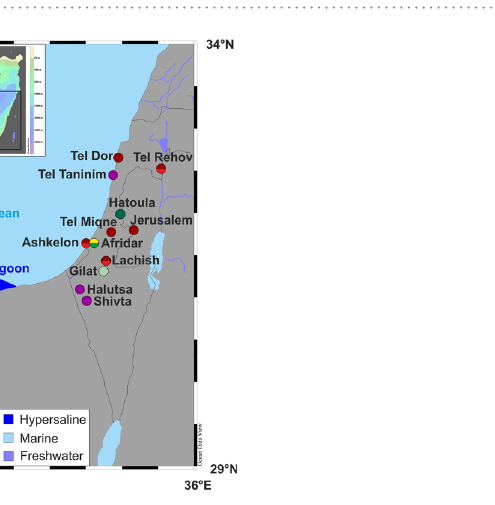
Figure 2. Map of archaeological sites in the southern Levant from the beginning of the Pre-Pottery Neolithic (PPN: ~9,700 years BCE) until the Byzantine period (BYZ: 300 to 600 CE), from which S . aurata remains were analysed for their phosphate oxygen isotope composition. Also indicated is the location of the hypersaline Bardawil lagoon along the north coast of Sinai, Egypt, which is the proposed source of S . aurata with high δ 18 O > PO4 values of